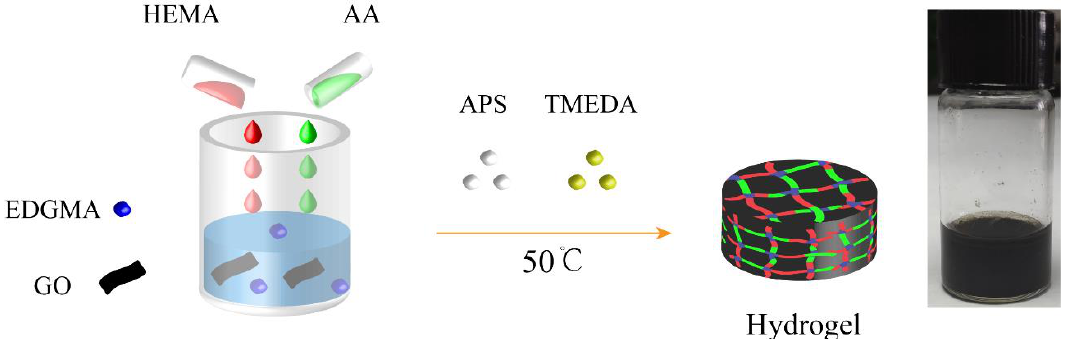
Figure 1. Schematic of Poly(acrylic acid- co -2-hydroxyethyl acrylate)/graphene oxide (P(AA-HEMA)/GO) hydrogels: the red segments are Poly(2-hydroxyethyl acrylate) (PHEMA), the green segments are Poly(acrylic acid)(PAA), and the blue segments are chemical crosslinking points.